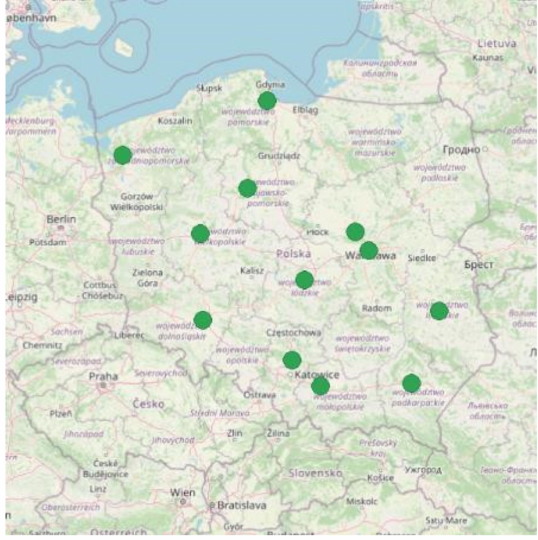
Figure 1. Localizations of examined airports. Source: own elaboration based on data from Table 1. Base map from © OpenStreetMap contributors 2021 [44]. Distributed under a CC BY-SA